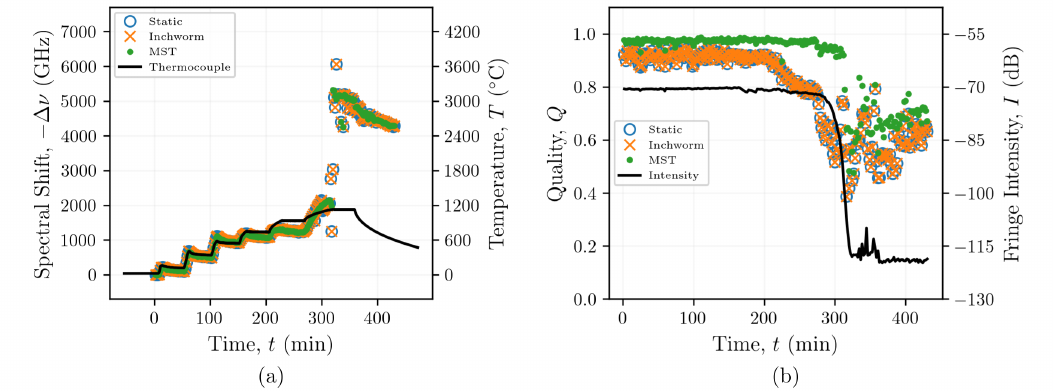
Figure 7. Spectral shifts ( a ) and qualities ( b ) from reconstructions of data from a heated optical fiber with Type-II FBGs using the static reference, inchworm algorithm, and MST post-processing